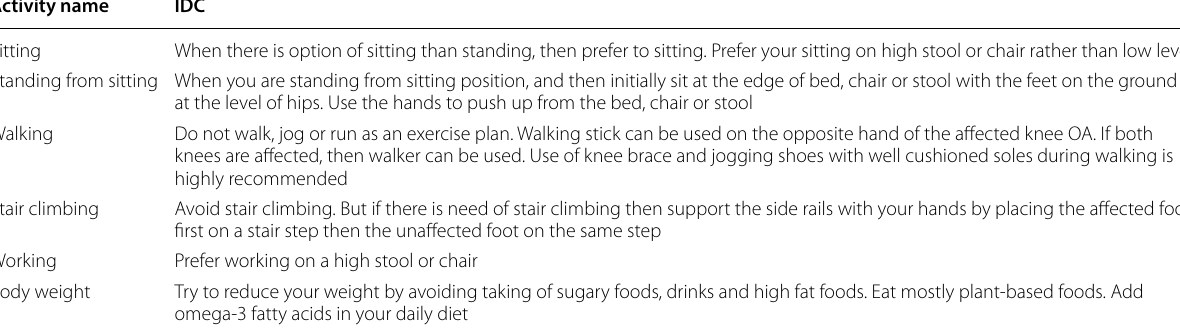
IDC, instructions of daily